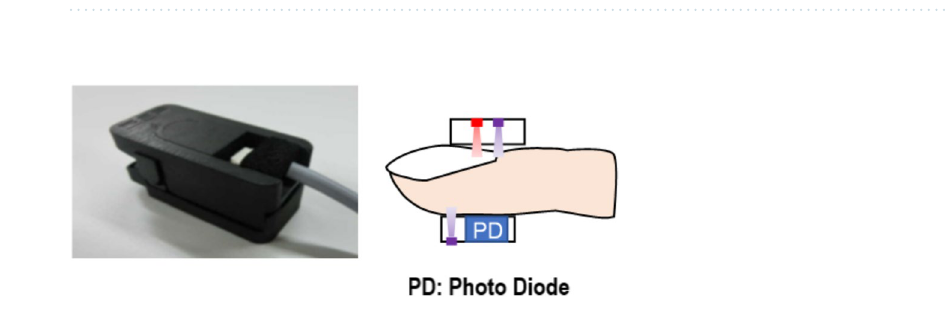
Table 1. Non-invasive methods for CO measurement. CO, cardiac output; MRI, magnetic resonance imaging.